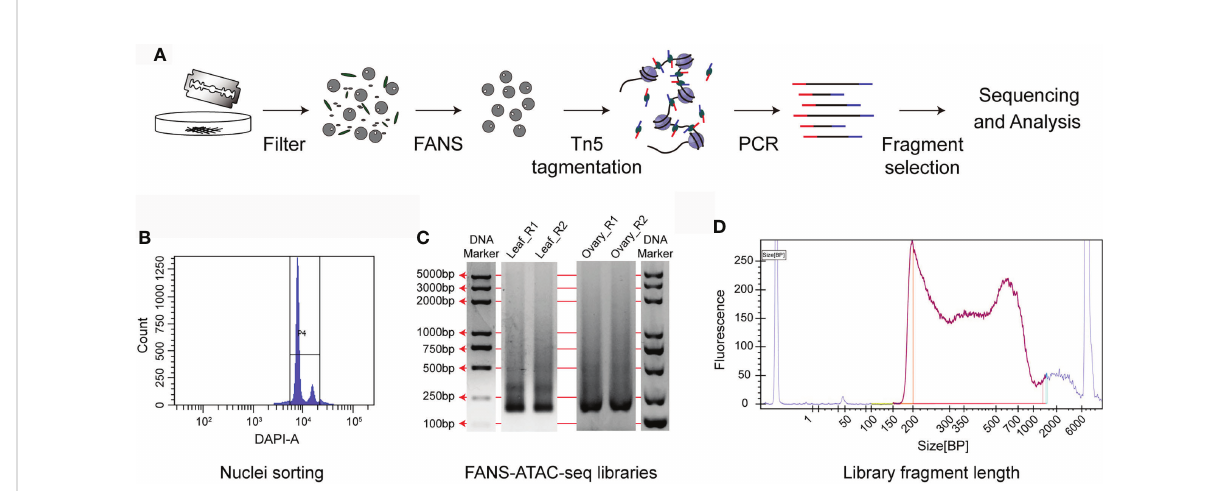
FIGURE 2 FANS-ATAC-seq protocol. (A) A schematic diagram of the FANS-ATAC-seq method, including nuclei preparation, sorting of nuclei and library construction. (B) P4 plot for the aboveground samples of 10-day old seedlings on fl ow cytometer. The nuclei sorting protocol was established based on the event number and DAPI fl uorescence intensity. (C) Merged agarose gel picture to show the representative ATAC-seq libraries obtained after FANS. Discrete bands representing the nucleosome fractions indicate high quality of FANS-ATAC-seq libraries. Leaf_R1 and Leaf_R2 represent the two repeats of aboveground samples of 10-day old seedling, Ovary_R1 and Ovary_R2 represent the two repeats of ovary at 2 days after pollination. (D) Distribution of fragment length of the libraries for young spike at double-ridge